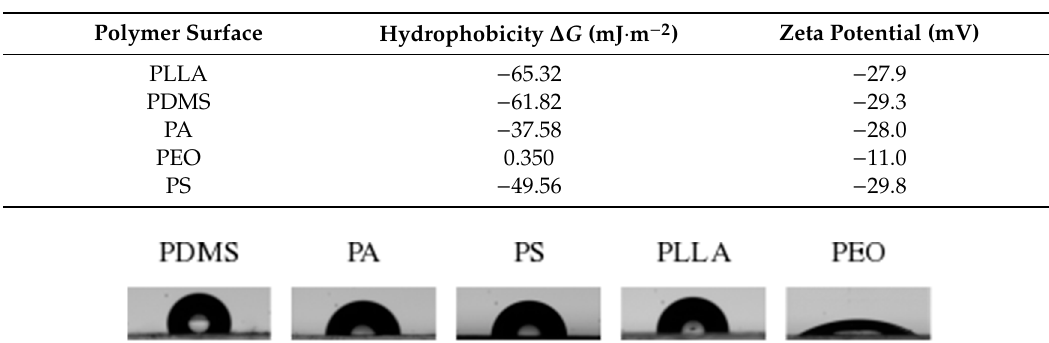
Figure 3. Water droplet over the surfaces of PDMS, PA, PS, poly-l-lactide acid (PLLA) and Polyethylene oxide (PEO) illustrating the hydrophobicity of the materials.